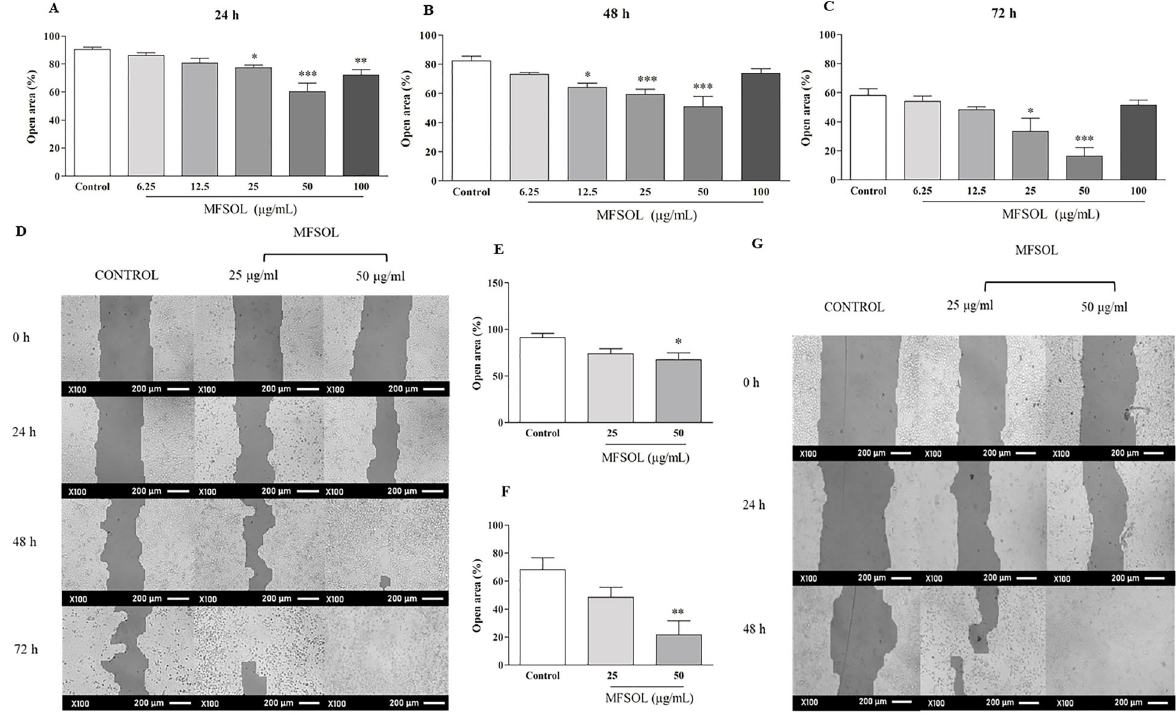
Figure 3. Methanol fraction of Sideroxylon obtusifolium (MFSOL) stimulated cell proliferation and migration rates of HaCaT in the scratch assay. A scratch was produced in a monolayer of HaCaTcells and photographs were taken, before (0 h) and 24 ( A ), 48 ( B ), and 72 h ( C ) after treatment with MFSOL (100 (cid:1) magni fi cation; scale bar 200 m m) ( D ). Pretreatment with mitomycin C (10 m g/mL) was also performed one hour before the introduction of the scratch to inhibit cell proliferation, allowing only evaluation of cell migration after 24 h ( E ) and 48 h ( F ). The wells were photographed (100 (cid:1) , scale bar 200 m m) after 24 and 48 h ( G ). The data are reported as means ± SE. *P o 0.05, **P o 0.01, ***P o 0.001 compared to the Control group (water) (one-way ANOVA followed by the Tukey (Figure 3D). Considering the stimulatory effect of MFSOL on cell proliferation and migration, we used mitomycin C to inhibit cell duplication and thus enable the isolated evaluation of the effect of MFSOL on cell migration. At the concentration of 50 m g/mL, it was ef fi cient in stimulating the migration of the cells to the center of the open area by 26% after 24 h (P o 0.05) and 67% after 48 h (P o 0.01) of incubation compared to the Control (Figure 3E, F, and G).